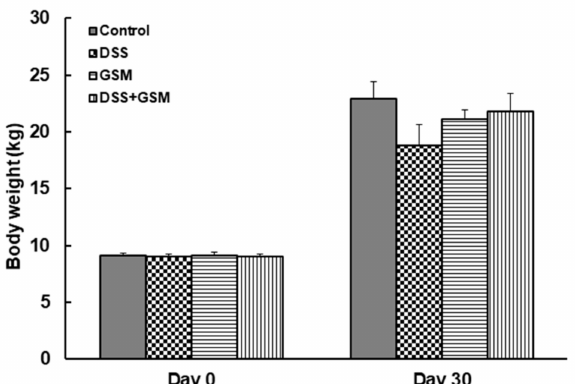
Figure 1. The effects of grape seed meal (GSM) diet on body weight evolution; unchallenged and dextran sulphate sodium (DSS)-treated pigs were assigned for 30 days to a control diet (Control and DSS groups) or 8% GSM diet (GSM and DSS + GSM groups). The body weight was recorded at the beginning and at the end of the experiment. The results, expressed are presented as mean ±